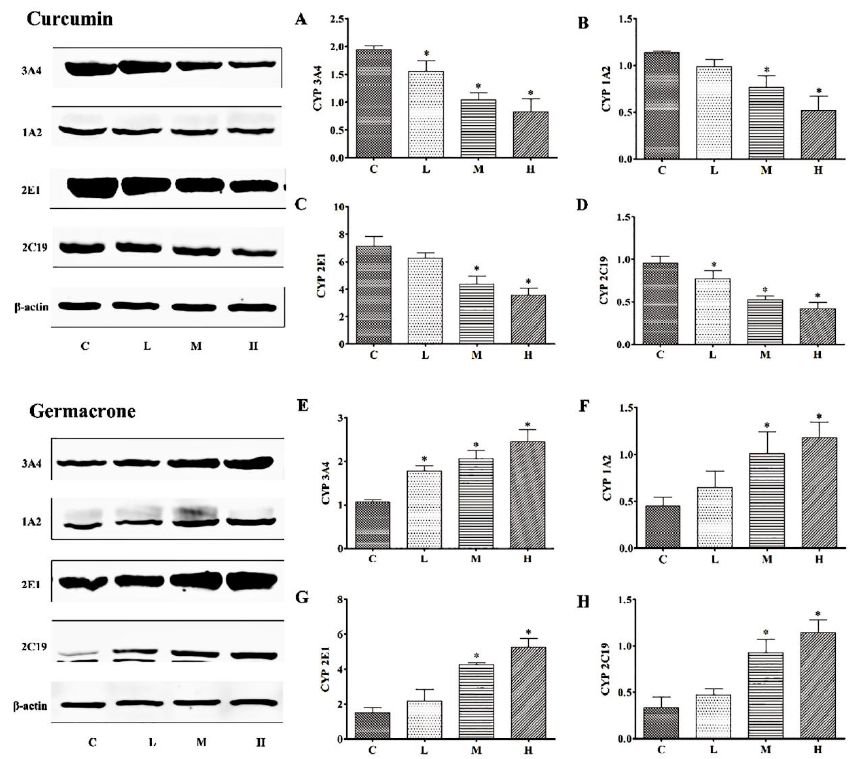
Figure 8. The expression levels of CYP3A4 ( A ), 1A2 ( B ), 2E1 ( C ) and 2C19 ( D ) were decreased in curcumin groups and CYP3A4 ( E ), 1A2 ( F ), 2E1 ( G ) and 2C19 ( H ) were increased in germacrone groups in vitro (mean ± SD, n = 6, * p < 0.05 vs. control rats). 2.8. Effect of Curcumin and Germacrone on the Protein Levels of CYP Enzymes In Vivo After 7-days curcumin treatment, compared with control group, the CYP3A4, 1A2, 2E1 and 2C19 protein levels were decreased in low-, medium- and high-dose group rats. As to the germacrone treatment, compared with control group, the CYP3A4 1A2, 2E1 and 2C19 protein levels were increased in low-, medium- and high-dose group rats. The protein expressions in vitro and in vivo had the same tendency for the two compounds. The results showed in Figure 9.